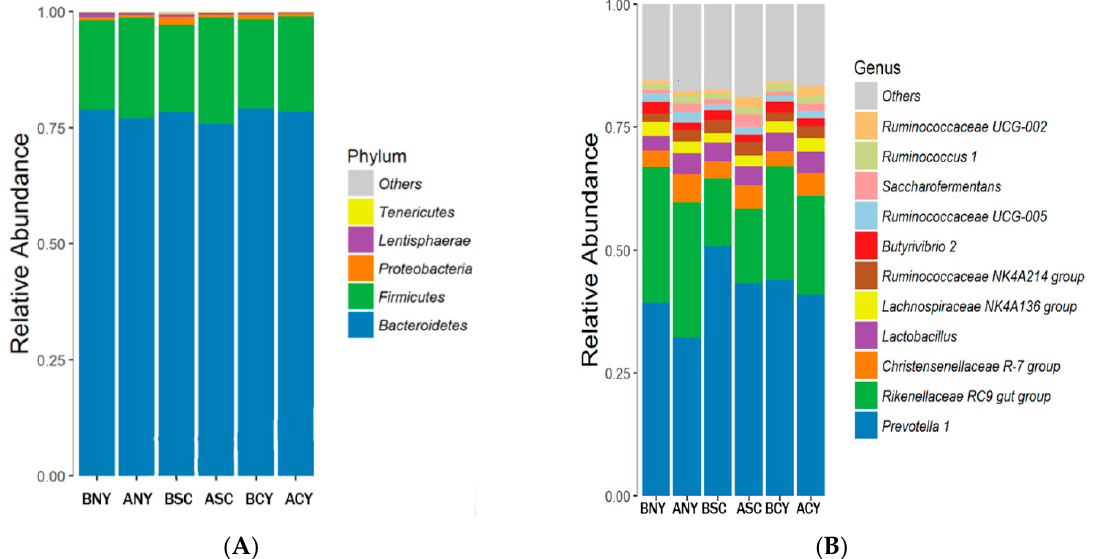
Figure 3. Bar plots showing the average relative abundance of bacterial phyla (%) in the rumen at the phylum level ( A ) and genus level ( B ). For each breed, B indicates before transport, and A indicates after transport. (For example, the Native Yellow (NY) group includes BNY and ANY, Simmental Crossbred Cattle (SC) group includes BSC and ASC, and Cattle Yak (CY) includes BCY and ACY) and transportation (before vs. after). Data represent the abundance at greater than 0.1% of the community between three beef breeds or between treatment groups (before and after transportation).